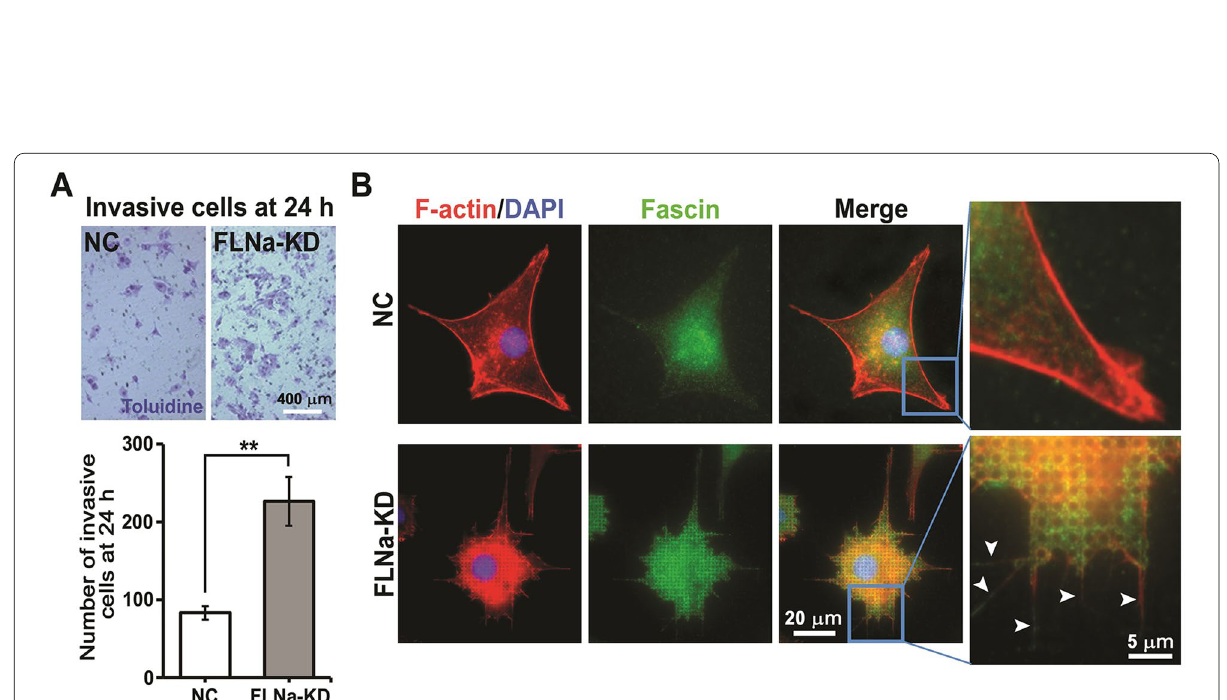
SD. (n 6 cells). *P < 0.05; ***P < 0.001; Student’s t-test ± =